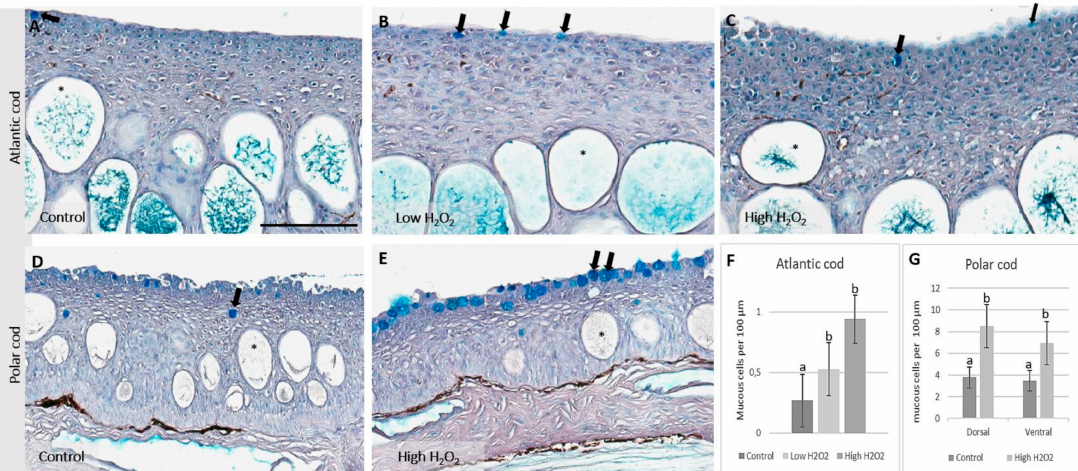
Figure 4. Histological evaluation of Atlantic cod and polar cod. Skin from Atlantic cod ( A ) control fish showing normal histology with a smooth outer epidermis and mucous cell (arrow). Exposure to low ( B ) and high ( C ) doses of H 2 O 2 increased the number of mucous cells (arrows) and the outer border became rougher. Skin from polar cod ( D ) control fish showed a rougher outer border and more mucous cells (arrow) compared to Atlantic cod. ( E ) Exposed fish had more mucous cells and rougher outer borders compared to control. Abundance of mucous cells increased in both species after exposure ( F , G ). Numbers are mucous cells per 100 µ m ± SD. Di ff erent letters mark significance ( p ≤ 0.05). Sections were stained with AB / PAS. Scale bar = 100 µ